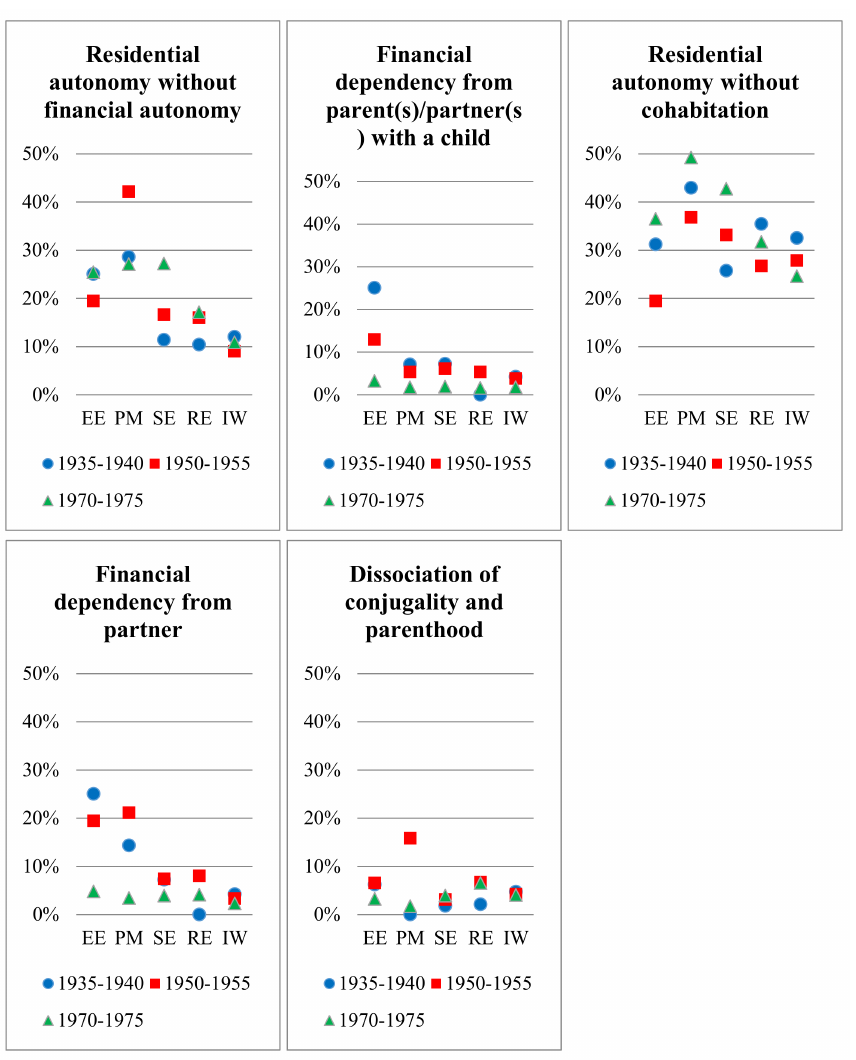
Figure 4. Changes to the normative order of transitions by sex and